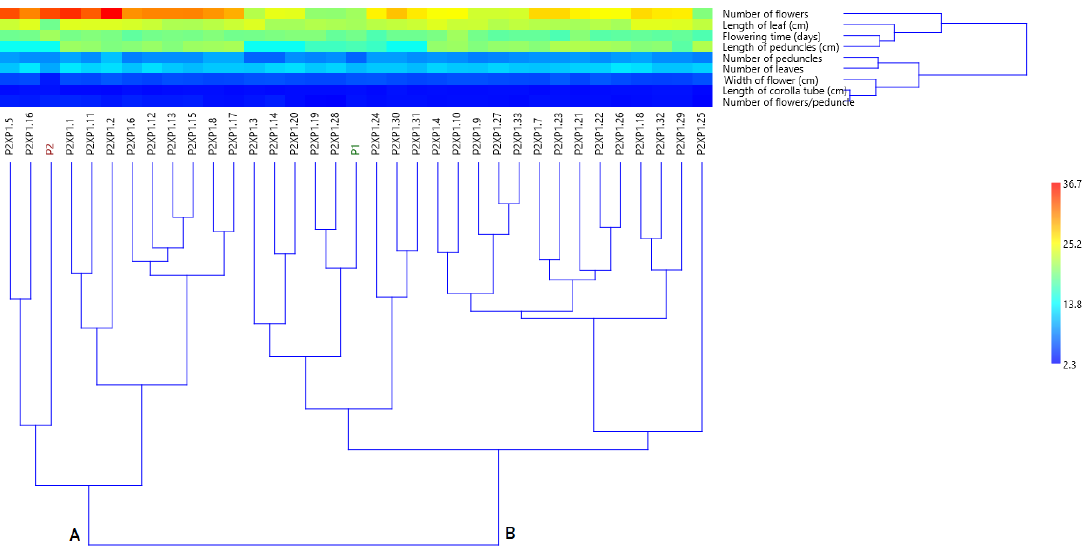
Figure 6. Two-way UPGMA dendrogram based on morphological traits, showing the relationships between parents (P1 and P2) and F 1 plants from P2×P1 cross and based on Euclidean’s distance index. In dendrogram, the mother parent is marked with red color, while the father parent is marked with green color. Concerning the analyzed morphological traits of P2×P1 plants, the two-way dendrogram revealed two main clusters. The upper one was represented by the length of leaf (cm), flowering time (days), length of peduncle (cm) and number of flowers/plant, which is strongly distanced from the others. The second main cluster grouped the